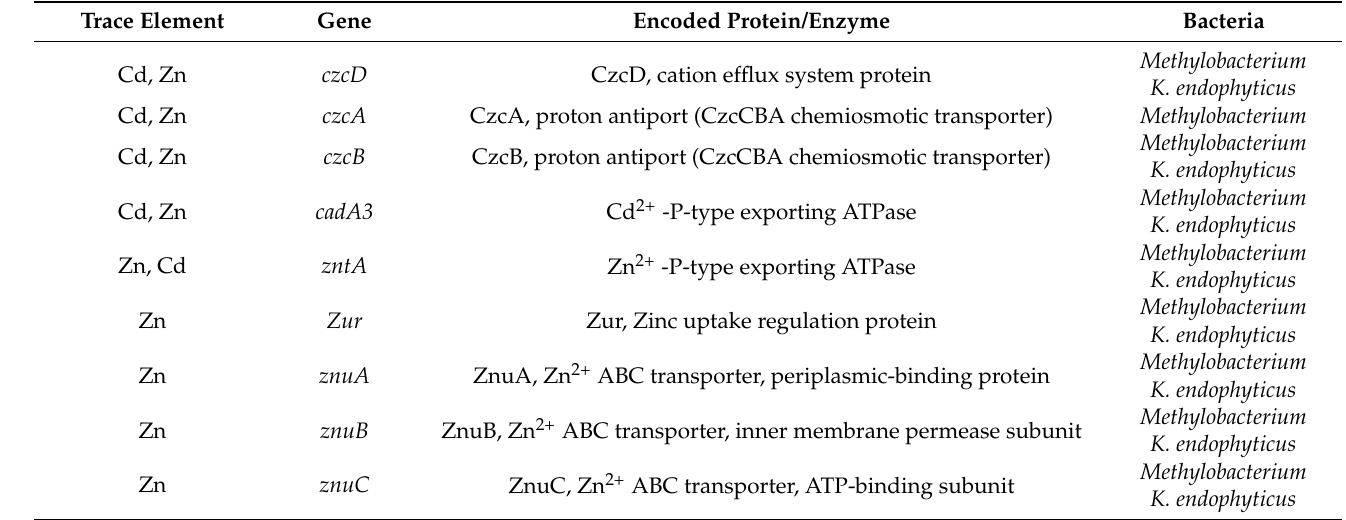
Table 2. Main genes and relative encoded protein involved in Kineococcus endophyticus CP19 and Methylobacterium sp. CP3 responses to Cd and Zn. ABC = ATP-binding cassette.